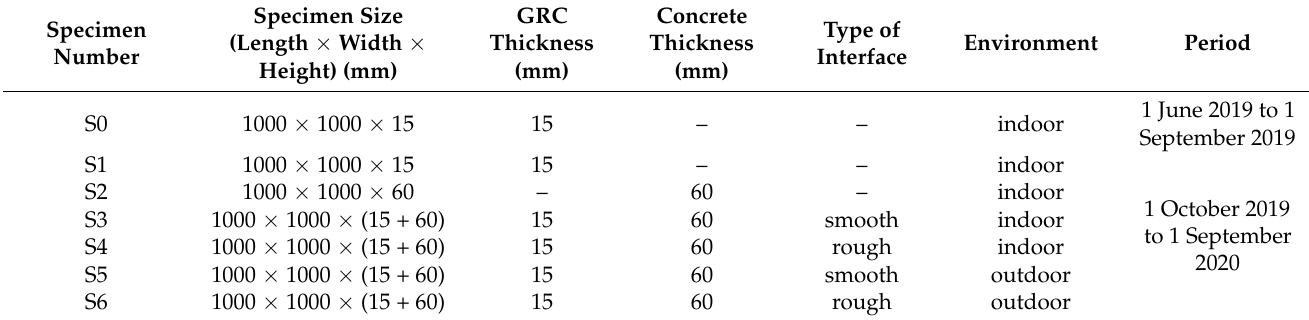
Figure 5. Three-dimensional model of a composite wall panel. Table 3. Dimensional parameters of GRC-PC composite wall